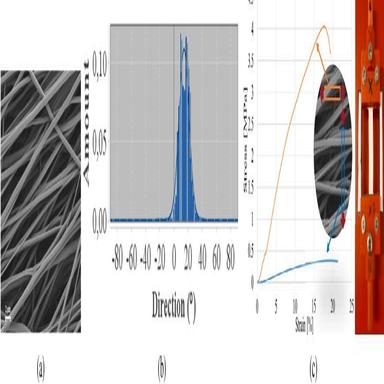
(a) SEM image of one specimen of the aligned nanofibers mat. (b) Directionality histogram. (c) Specimen anchored in a paper frame, and tensile test results in the longitudinal and transverse direction with respect to the alignment direction of the nanofibers.